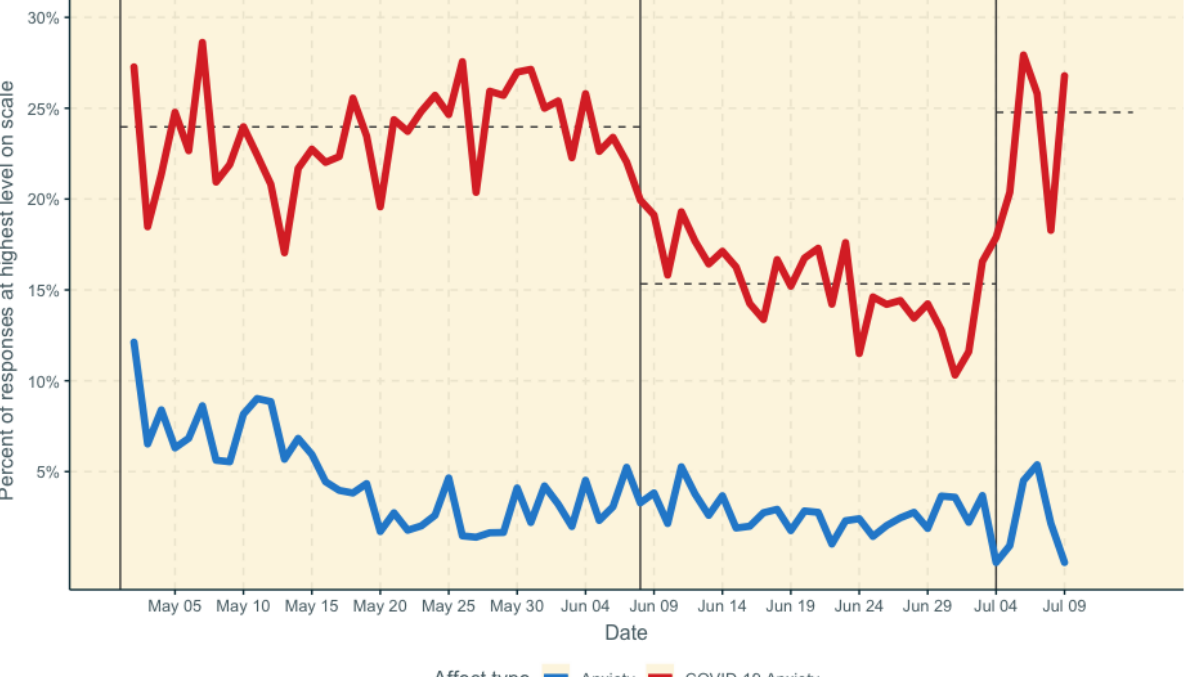
Figure 1. Daily proportion of responses at highest levels of anxiety about COVID-19 and non–COVID-19–specific anxiety. Vertical lines indicate breakpoints in COVID-19 anxiety from the structural change model. Horizontal lines indicate mean during each